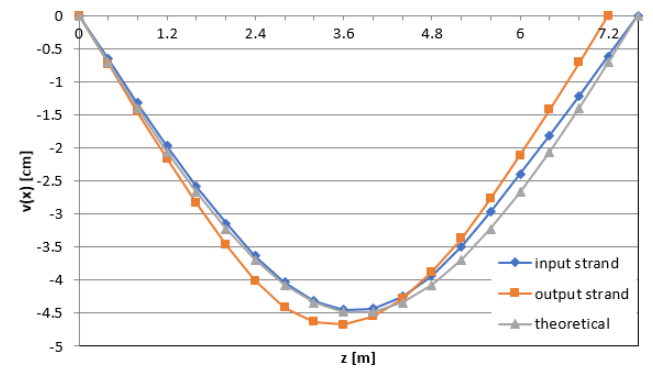
Figure 10. Centerline deformation imposed at 4.5 cm.